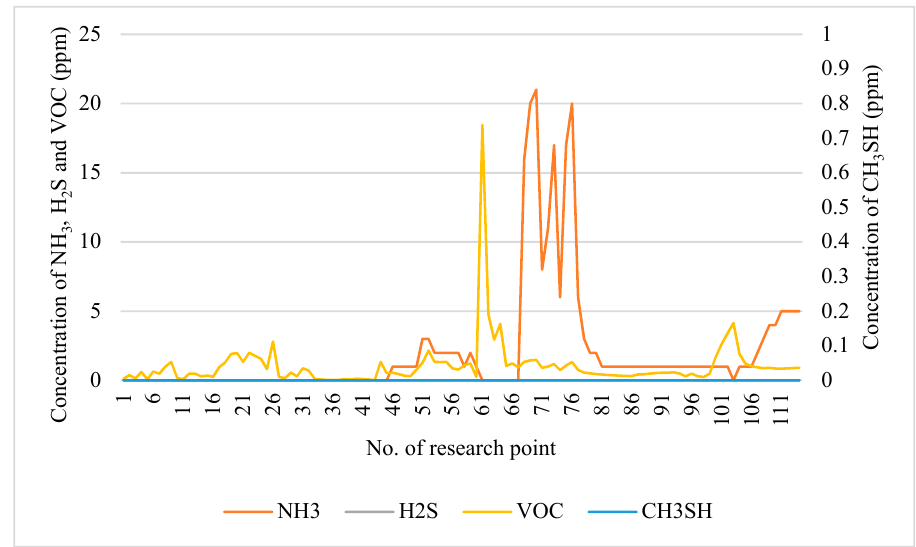
Figure 2. Diagram showing odorant measurement results in the biogas plant in Stalowa Wola (own elaboration based on ProRae Studio